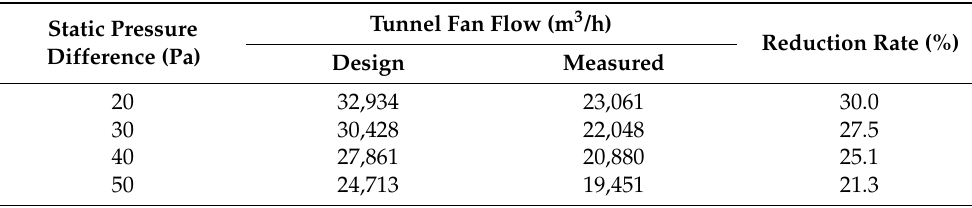
Table 4. Flow rate reduction rate of design fan curve and field fan performance curve according to static pressure